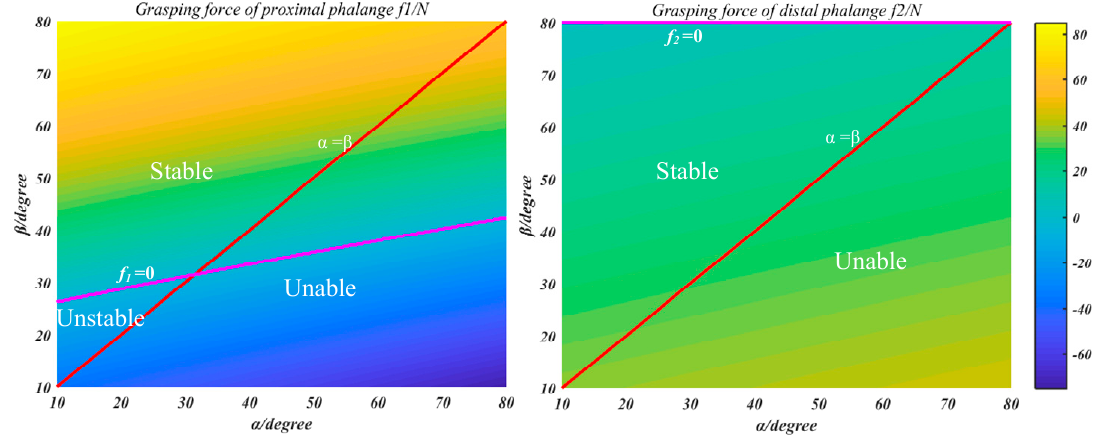
Figure 17. Stability analysis for the COSA